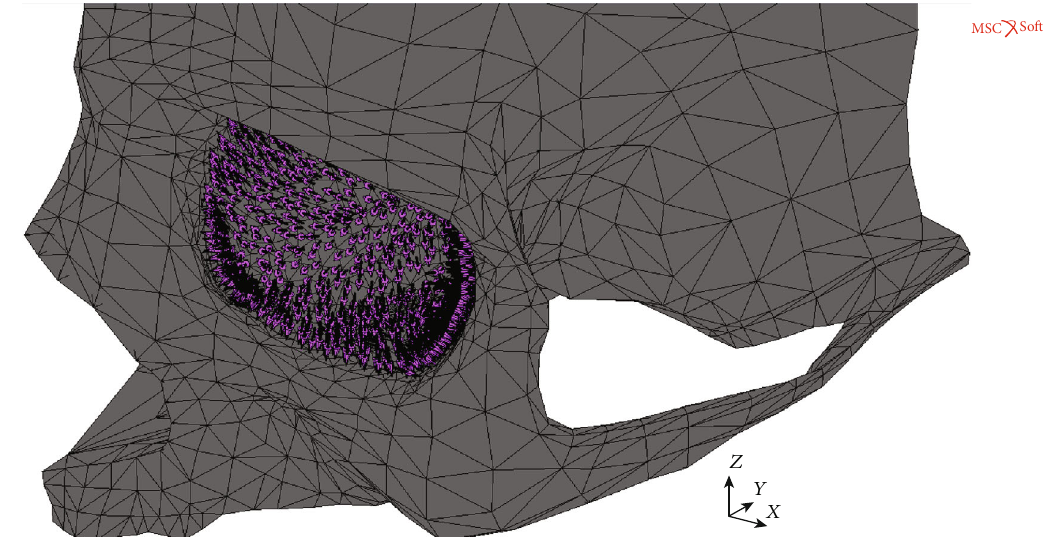
Figure 1: MOBE under the face loads applied to shell elements inside the orbit.